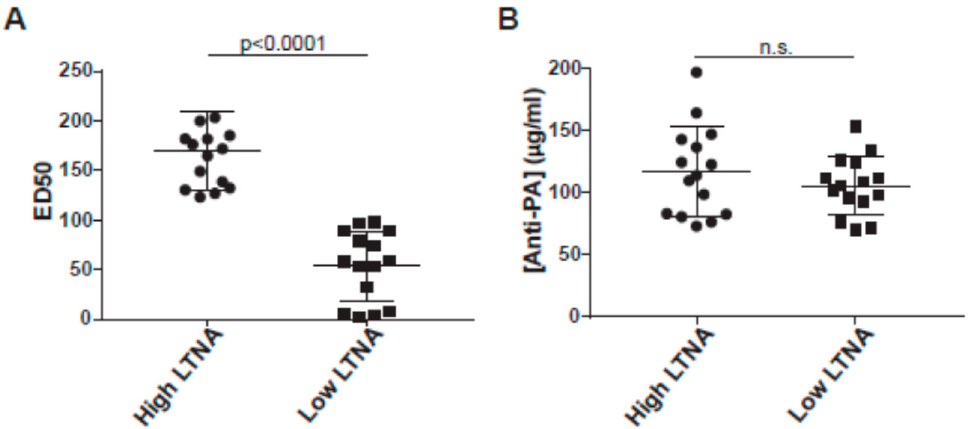
Figure 2. Characteristics of the high and low neutralizing matched cohort. ( A ) High neutralizers were defined as those subjects with ED50 higher than 100 and ( B ) were matched with low neutralizers, defined as those subjects with ED50 below 100, on anti-PA concentration. Data from high neutralizers are shown as circles, data from low neutralizers are shown as squares.